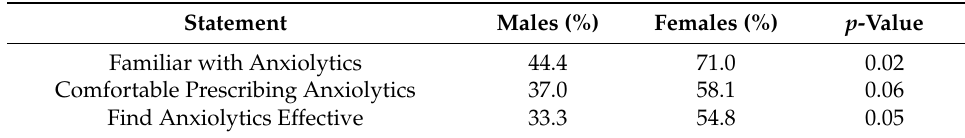
Table 4. Gender differences in Ohio dentists’ familiarity, comfort, and belief in efficacy of anxiolytics for the relief of dental